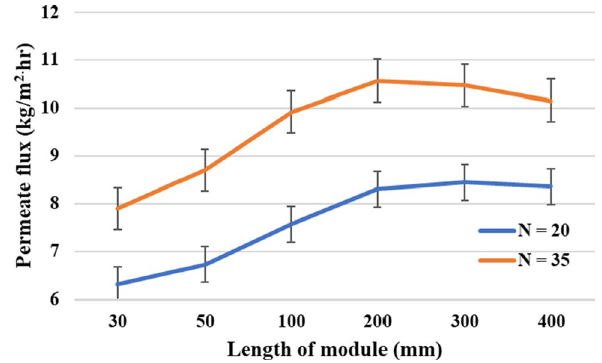
Fig. 15 Effect of operating parameters on GOR with design param- eters set to base line value as per Table